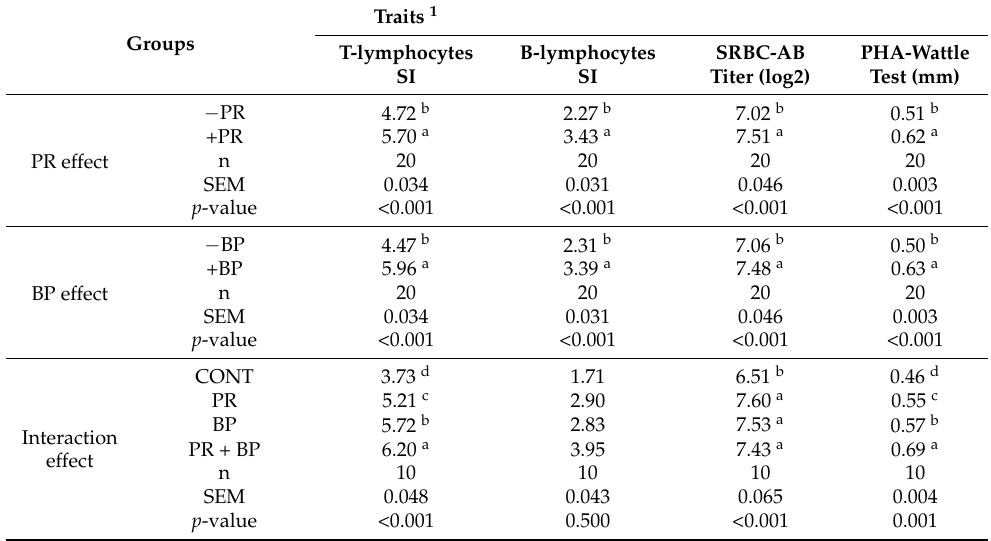
Table 6. Effect of propolis (PR), bee pollen (BP), and their interaction (PR + BP) on lymphocyte proliferation and humoral and cellular immunity of broiler chickens.